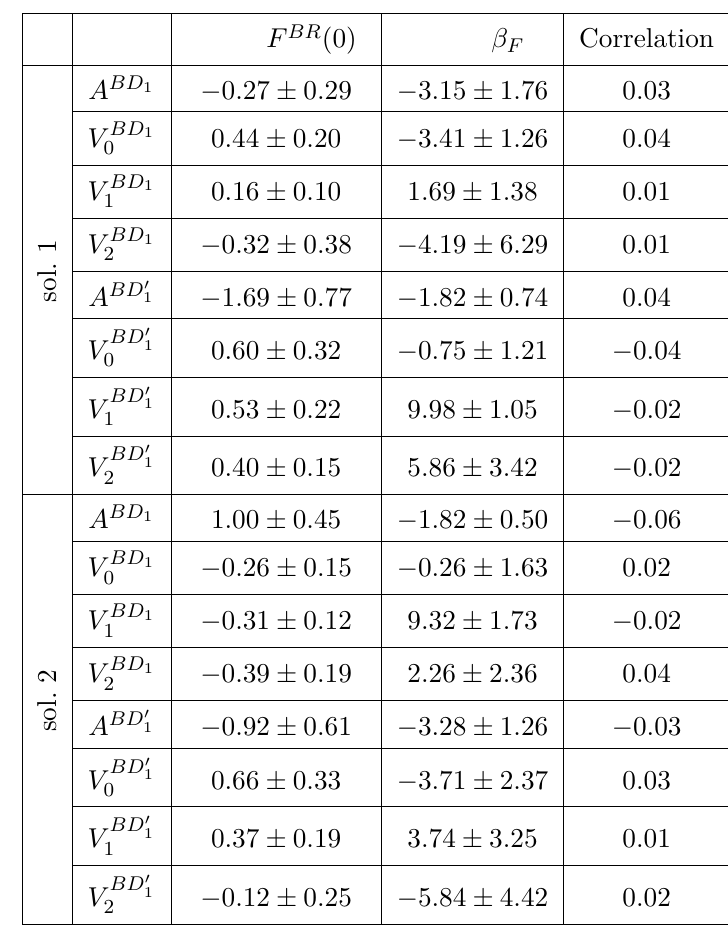
Table 4 . The central values, 1 σ uncertainties, and correlations of the coefficients of the form factor parametrization